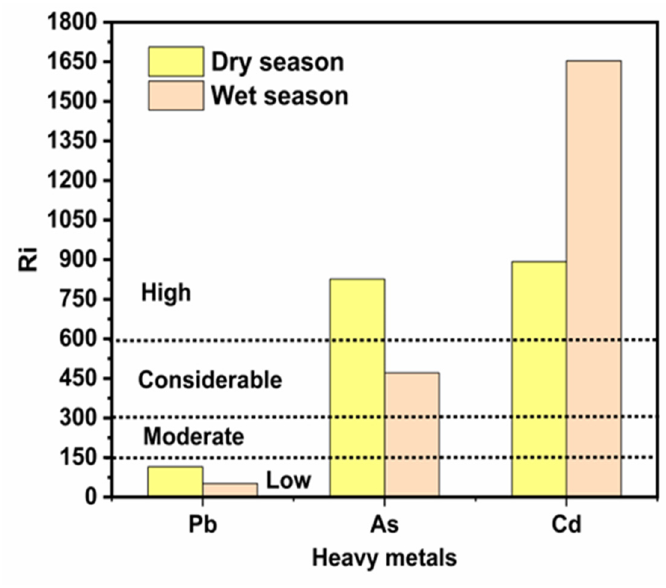
Figure 3. The values of the potential ecological risk index.